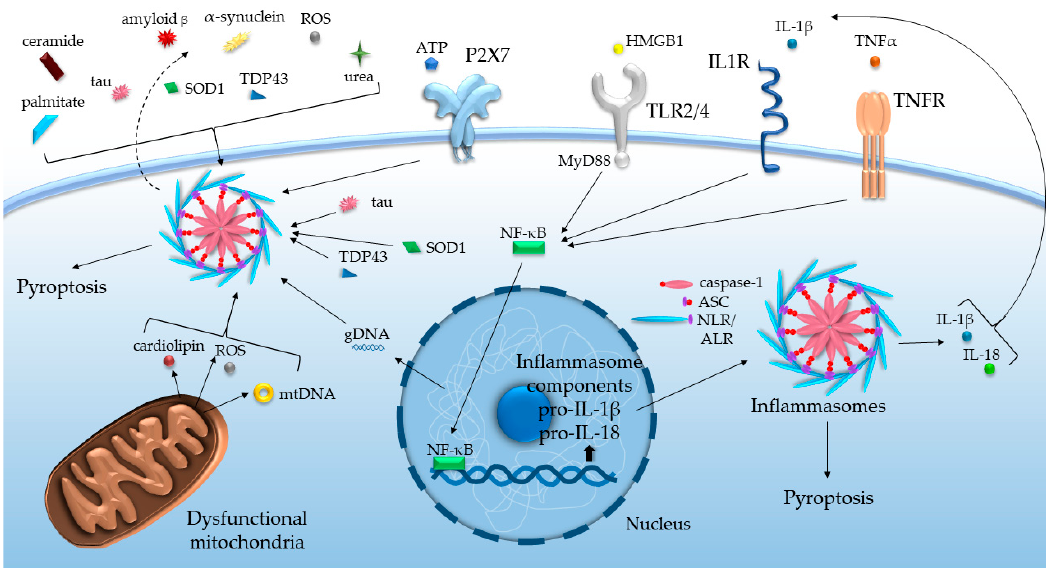
Figure 1. Inflammasome activation by various age-related DAMPs and cytokines. ALR: absent in melanoma 2-like receptor, ASC: apoptosis-associated speck-like protein containing a caspase recruitment domain, ATP: adenosine triphosphate, gDNA/mtDNA: genomic/mitochondrial deoxyribonucleic acid, HMGB1: high mobility group box-1, IL: interleukin, IL1R: interleukin-1 receptor, MyD88: Myeloid differentiation primary response 88, NF- κ B: nuclear factor kappa-light-chain-enhancer of activated B cells, NLR: nucleotide-binding oligomerization domain-like receptor, ROS: reactive oxygen species, SOD1: superoxide dismutase 1, TDP43: TAR DNA-binding protein 43, TLR: Toll-like receptor, TNF(R): tumor necrosis factor (receptor).